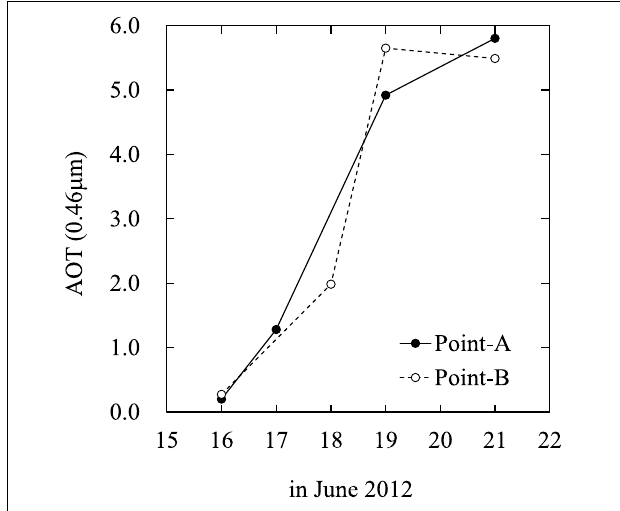
FIGURE 3 | AOT (0.46 µ m) at points-A (the solid line) and B (the dashed line) from 16th to 22nd June in